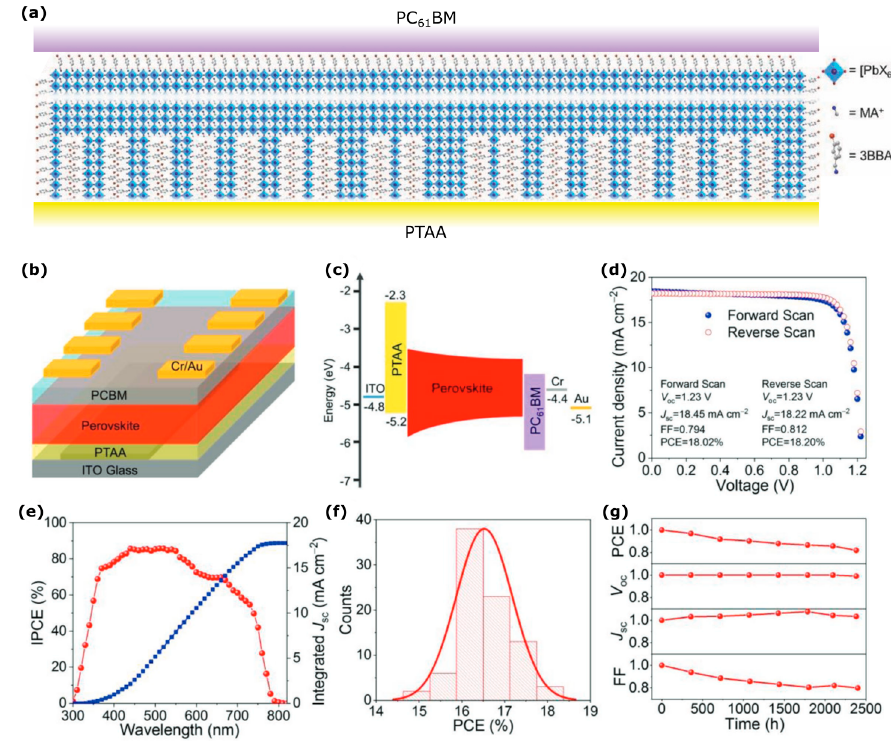
Figure 9. 2D perovskite solar cells using 3-bromobenzylammonium iodide barrier molecule. ( a ) Schematic of the device nanostructuring, ( b ) schematic of the device architecture, ( c ) energy band alignment relative to the vacuum level in eV, ( d ) current density-voltage measurement, ( e ) incident photon conversion e ffi ciency (ICPE), ( f ) histogram showing reproducibility of the power conversion e ffi ciency (PCE) and ( g ) solar cell stability for devices stored in the dark between measurements under ≈ 40 relative humidity. Reproduced with modifications for clarity from ref. [24], with permission from John Wiley and Sons, 2018.